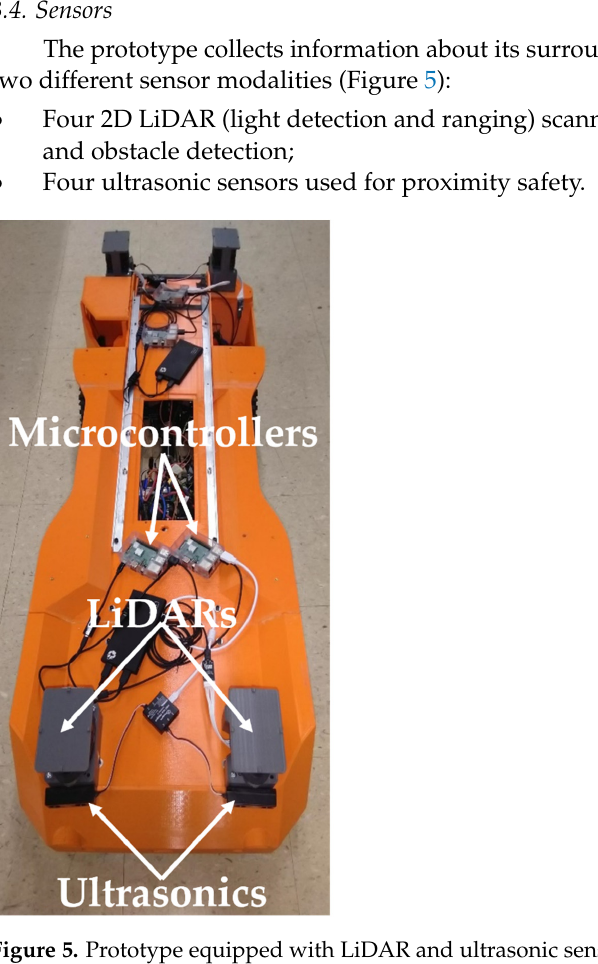
Figure 4. Top view of the shuttle car body (STP file).